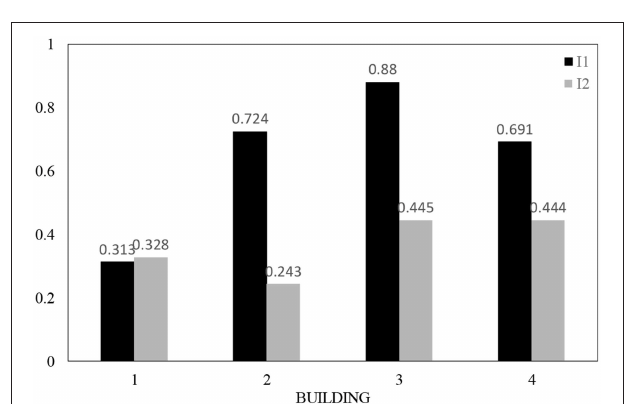
FIGURE 16 | The I 1 and I 2 indices given by